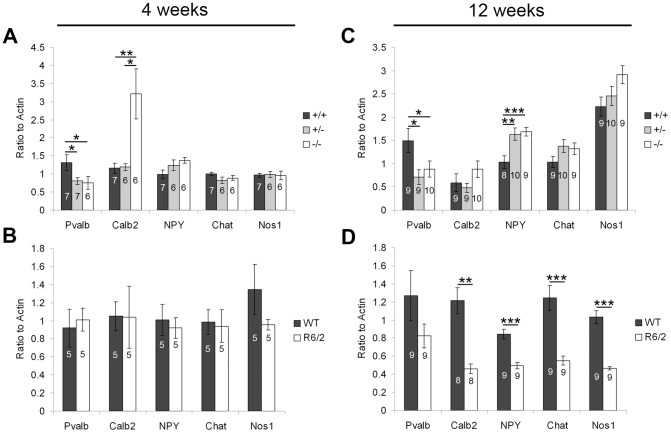
Transcriptional profile of interneuron markers.Gene expression of parvalbumin (Pvalb), calretinin (Calb2), neuropeptide Y (NPY), choline acetyltransferase (Chat), and neuronal nitric oxide synthase (Nos1) was measured in striatum of PGC-1α and R6/2 HD mice and littermate controls at four and twelve weeks using q-RT-PCR. A. At four weeks of age, Pvalb was significantly decreased in PGC-1α −/− and +/− compared to +/+ mice, and Calb2 was significantly increased in PGC-1α −/− compared to +/+ and +/− mice. B. No changes in interneuron markers were observed in R6/2 HD mice at this age. C. At twelve weeks of age, Pvalb was still significantly decreased in PGC-1α −/− and +/− compared to +/+ mice, and expression of NPY was significantly increased in −/− and +/− compared to +/+ mice. D. In the R6/2, all interneuron markers except Pvalb were significantly decreased at this age. For A and C, one-way ANOVA followed by Fisher's LSD. For B and D, two-tailed t-tests. *p<0.05. **p<0.005. ***p<0.0005. n/group indicated on histograms. Data presented as mean ± SEM.